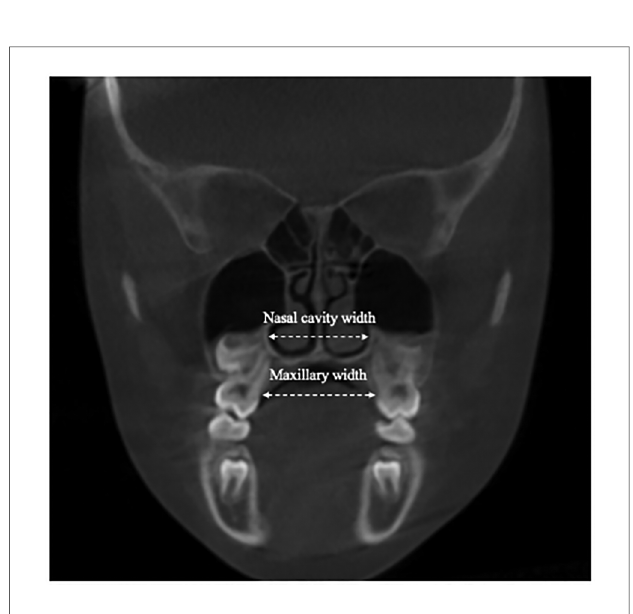
FIGURE 3 The coronal section on the fi rst molars. The maxillary and nasal width are measured from the palatal alveolar ridge of the fi rst molar to the other